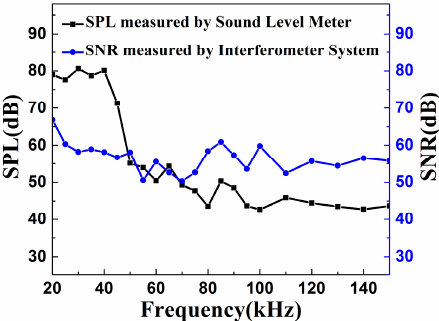
Figure 5. The relationship between frequency and the signal-to-noise ratio (SNR) of the sensor system.